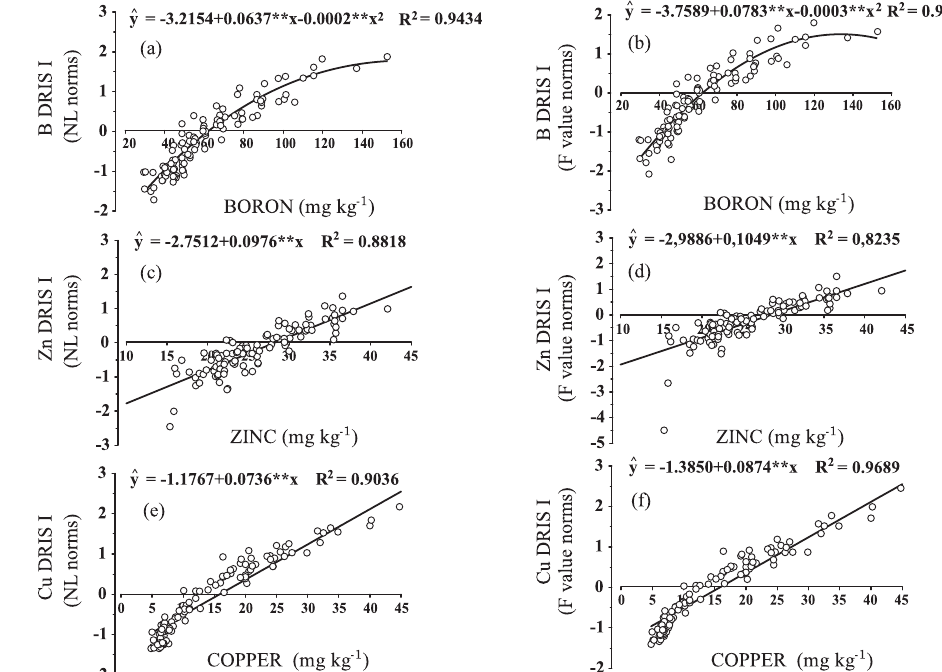
figure 3. Ratio between the levels of the micronutrients (reference and non-reference population), boron, zinc and copper and their respective DRis indices (DRis i), generated by the norms based on the criterion of natural log transformation (nl) (a, c and e) and the norms defined by the f value (b, d and f). ** p <